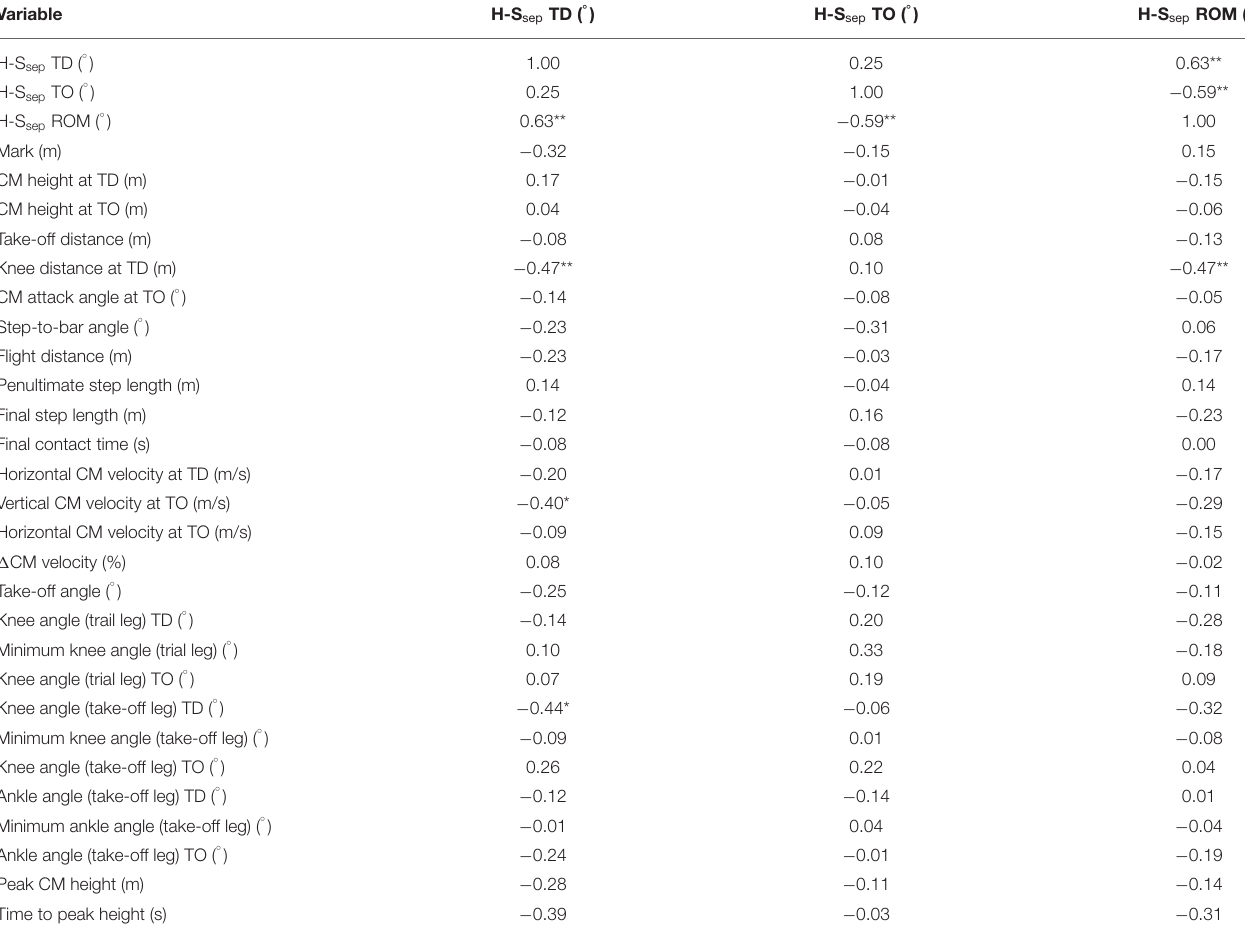
TABLE 4 | Correlation coefficients (full cohort) between technique-related variables and hip-shoulder positioning parameters at touchdown and toe-off.